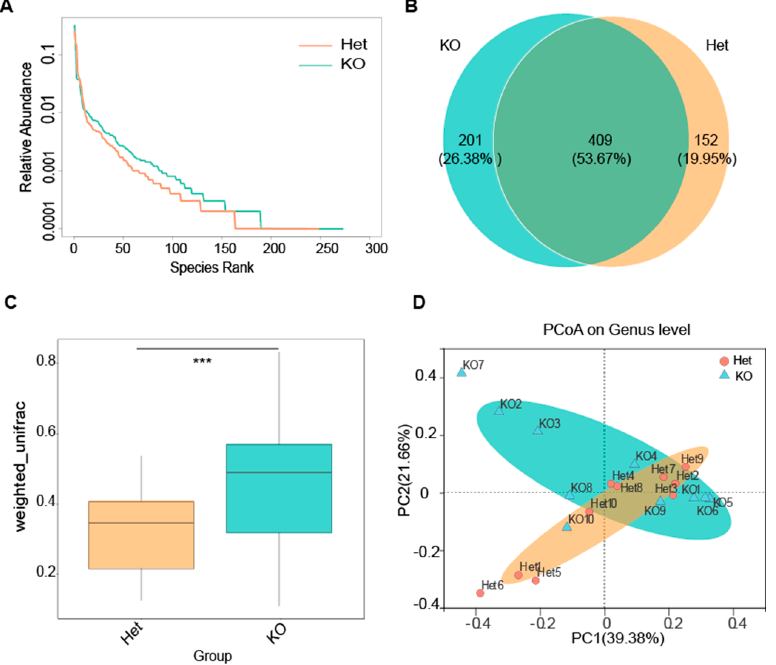
Figure 2. Deletion of the Vsig4 gene increased intestinal microbial diversity in mice gut. ( A ) KO mice have more abundant microbial species in gut. The abscissa of the curve is the serial number sorted by OTUs abundance, and the ordinate is the relative abundance of the corresponding OTUs. The higher the species richness, the larger the span of the curve on the horizontal axis; the smoother the curve, the more even the species distribution. ( B ) Venn diagram based on OTU. The number in the overlapping part represents the number of OTUs shared by the two groups, and the number without the overlapping part represents the number of unique OTUs in the group. ( C ) Box plot for analysis of differences between groups in Beta diversity, tested by t -test, *** p < 0.001, error bars represent SD. ( D ) PCoA shows the differences in the community composition of the samples at the genus level. KO, Knockout; Het, Heterozygote; OUT, Optical Transform Unit; PCoA, Principal coordinates analysis.